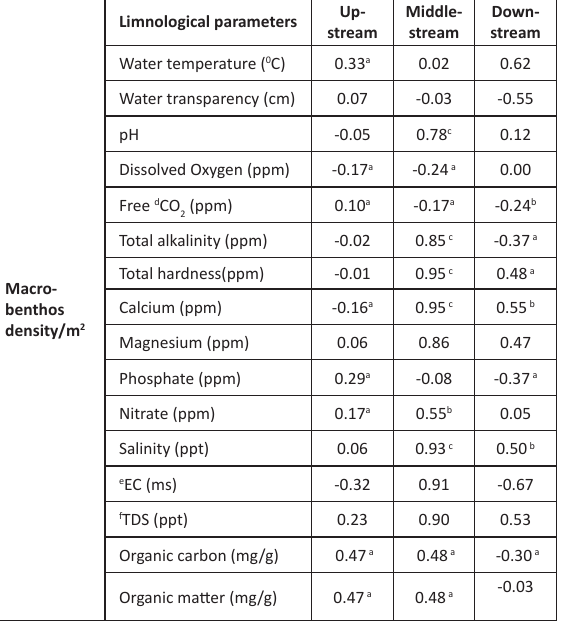
Table 7. Correlation among limnological parameters and benthic macroinvertebrates density at